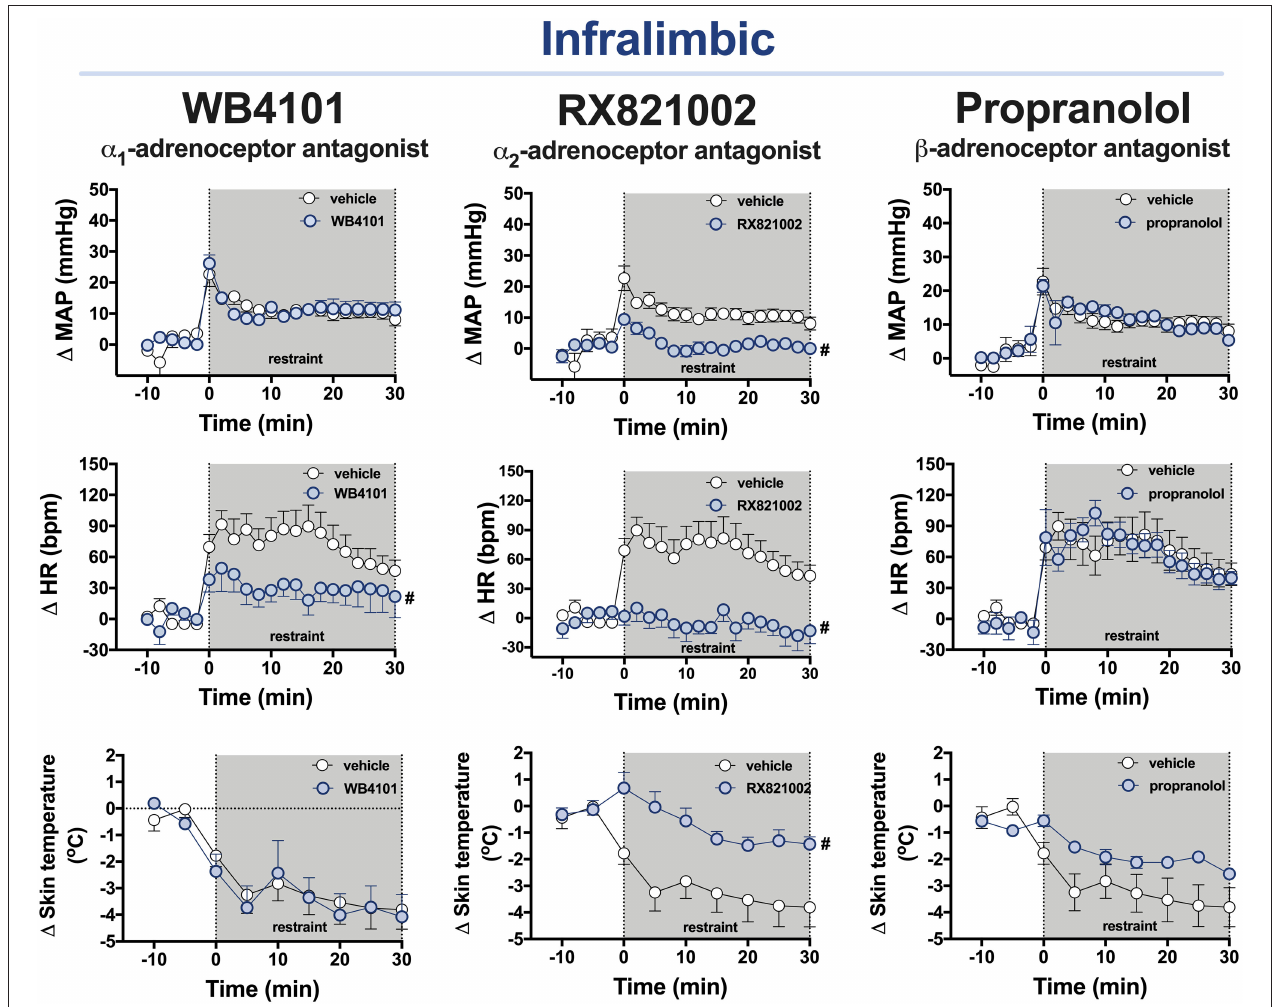
FIGURE 3 | Time-course curves of the mean arterial pressure ( 1 MAP), heart rate ( 1 HR), and tail skin temperature ( 1 skin temperature) changes evoked by an acute session of restraint stress in animals treated with the selective α 1 -adrenoceptor antagonist WB4101 (10 nmol/100 nl, n = 7), the selective α 2 -adrenoceptor antagonist RX821002 (10 nmol/100 nl, n = 6), the β -adrenoceptor antagonist propranolol (10 nmol/100 nl, n = 8), or vehicle (100 nl, n = 9) into the PL cortex. Circles represent the mean ± SEM. # P < 0.05 over the entire restraint stress period compared with the control group (vehicle), two-way